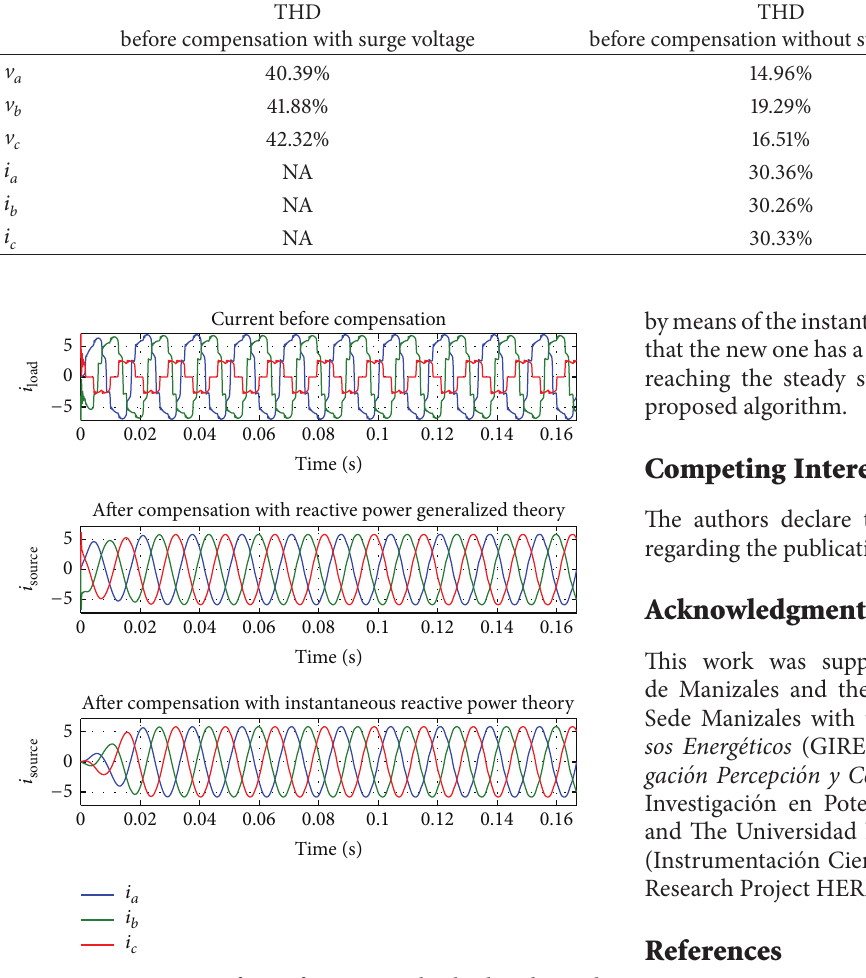
Figure 11: Current waveforms for a particular load and signal reference estimated with two different algorithms. Comparison of the proposed algorithm and [12]